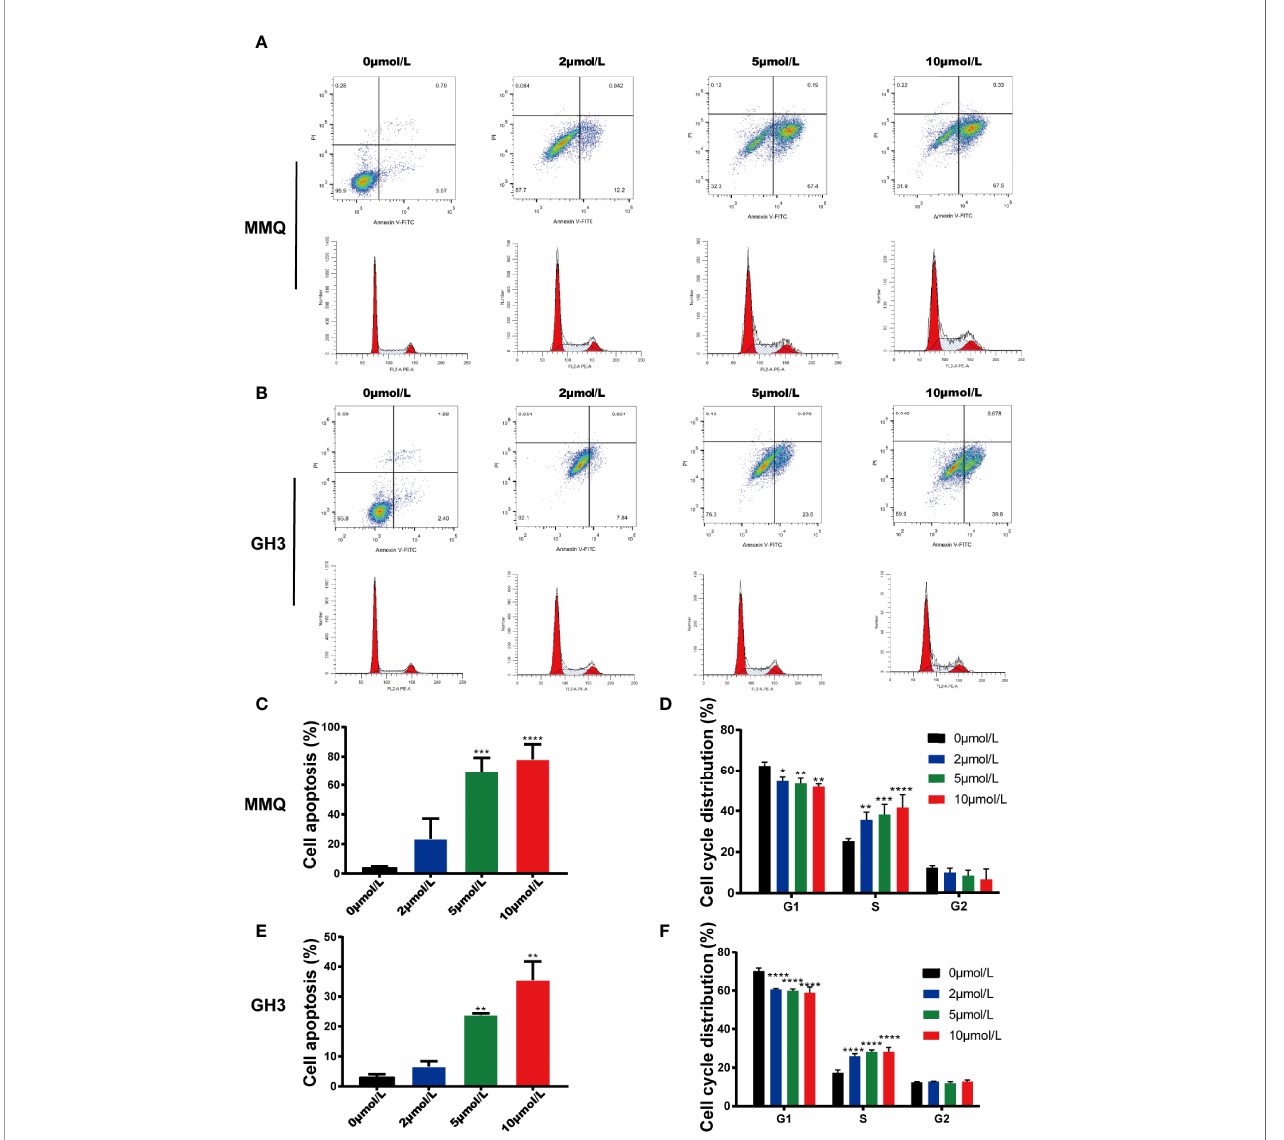
FIGURE 4 | HI-TOPK-032 induced apoptosis and cycle arrest of pituitary tumor cells. (A) Flow cytometry detected the apoptosis and cell cycle distribution of MMQ cells after HI-TOPK-032 intervention. (B) Flow cytometry detected the apoptosis and cell cycle distribution of GH3 cells after HI-TOPK-032 intervention. (C) HI- TOPK-032 induced apoptosis of MMQ cells. (D) HI-TOPK-032 down-regulated the percentage of G1 phase and up-regulate the percentage of S phase in MMQ cells. (E) HI-TOPK-032 induced apoptosis of GH3 cells. (F) HI-TOPK-032 down-regulated the percentage of G1 phase and up-regulate the percentage of S phase in GH3 cells. * P < 0.05; ** P < 0.01; *** P < 0.001; **** P <